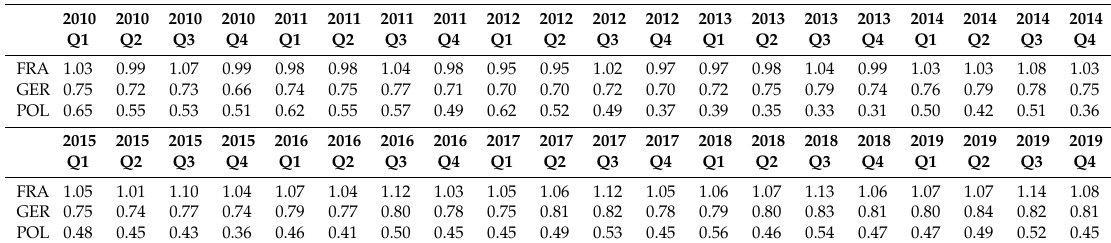
Table 8. Investment multiplier, own work, source: Eurostat.